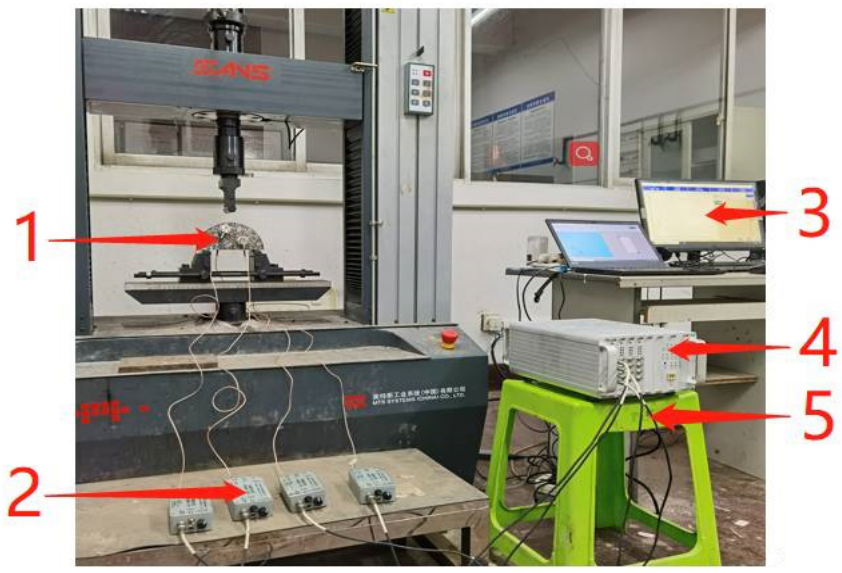
Figure 5. AE test system: 1: G8 sensors; 2: Preamplifier; 3: Computer; 4: High-speed digital AE detector; 5: Cable.